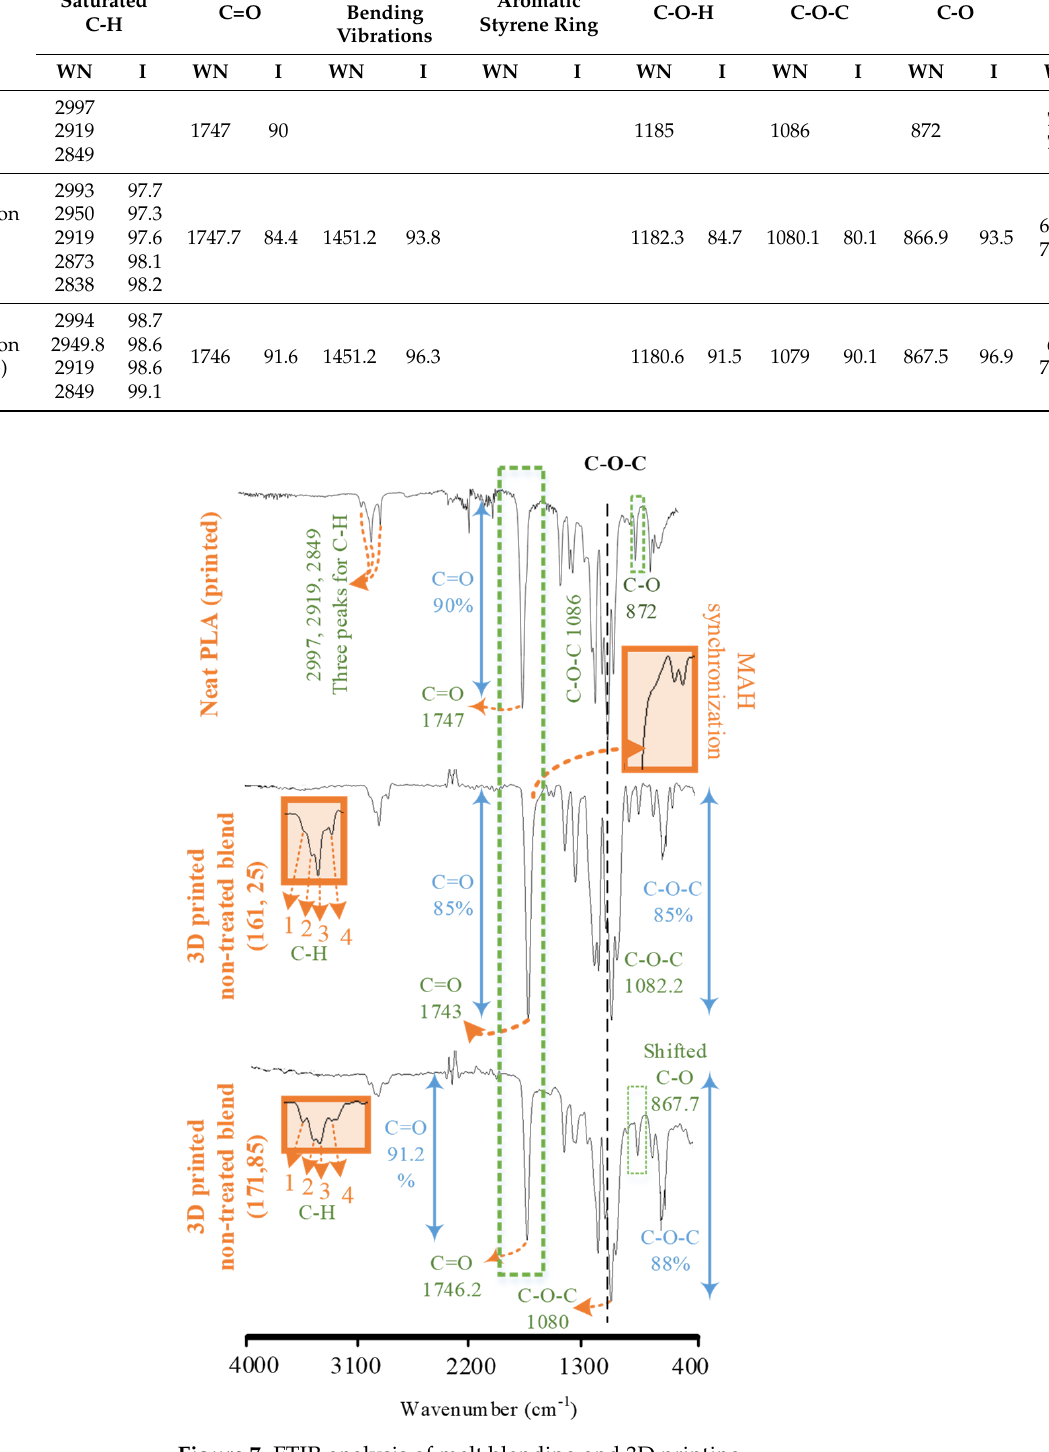
Figure 7. FTIR analysis of melt blending and 3D printing.